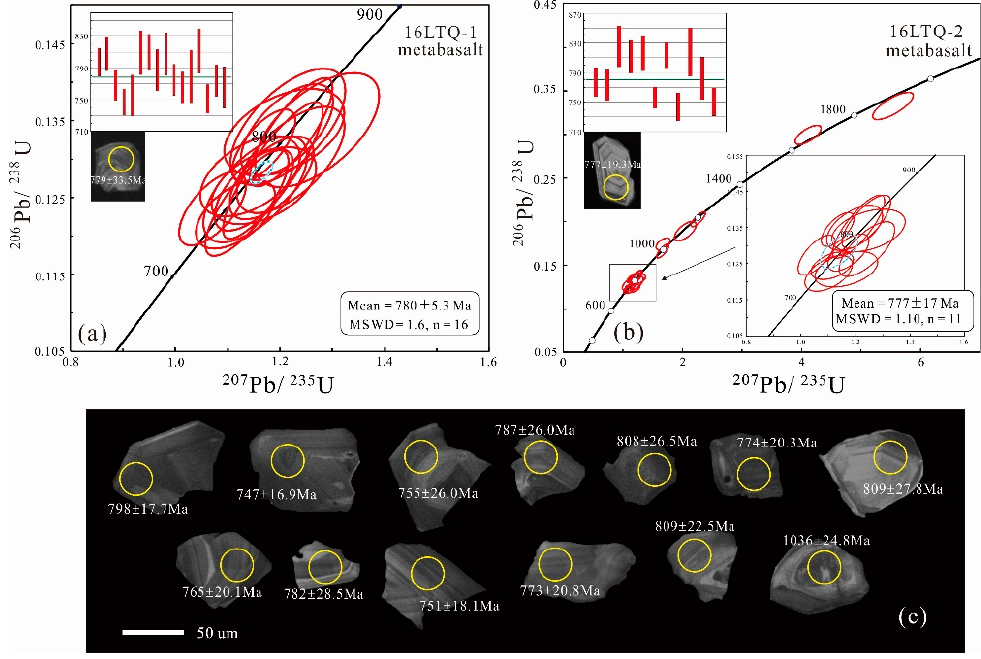
Figure 4. Zircon LA-ICPMS U–Pb concordia diagrams ( a , b ) and representative cathodoluminescence (CL) images ( c ) of laser ablated zircon crystals from the LTQ.